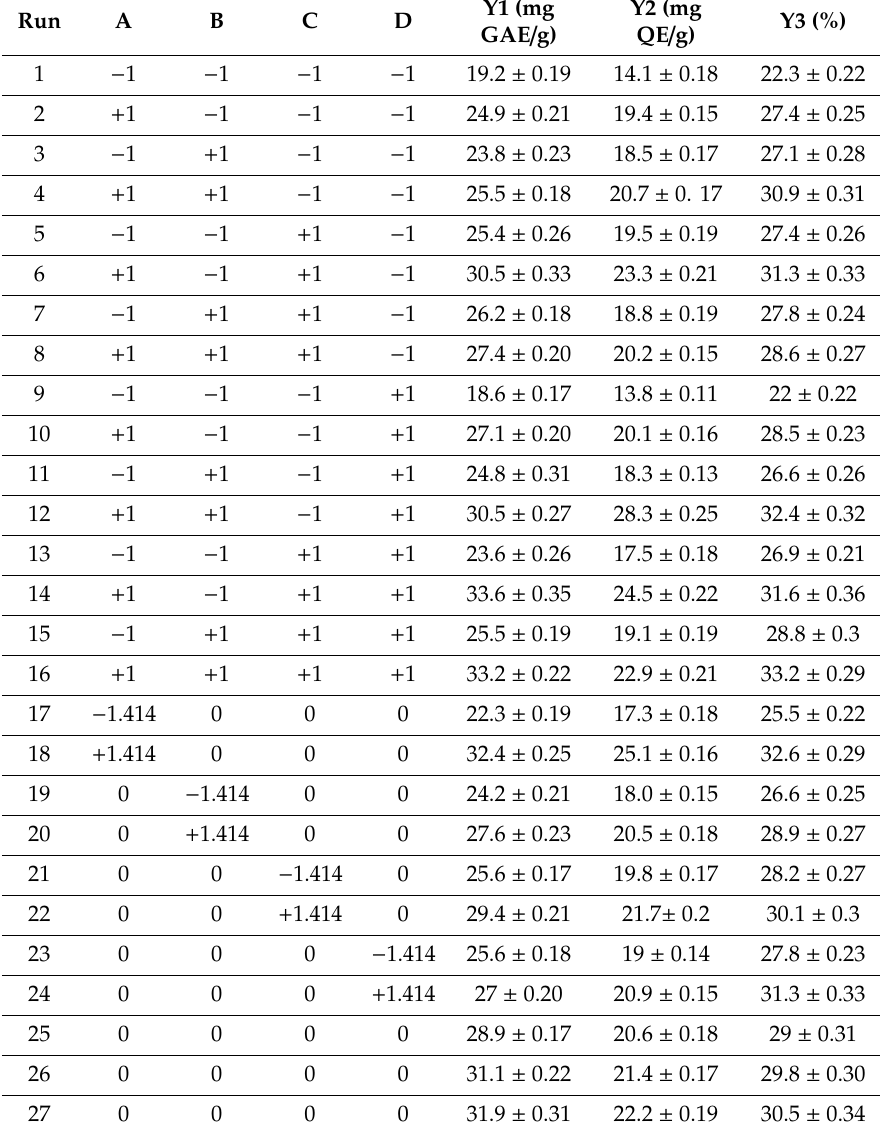
Table 2. Experimental design and response